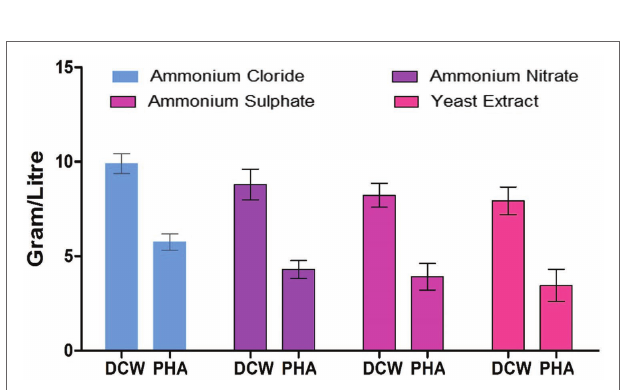
FIGURE 7 | Effect of different nitrogen sources on PHA production by P. aeruginosa